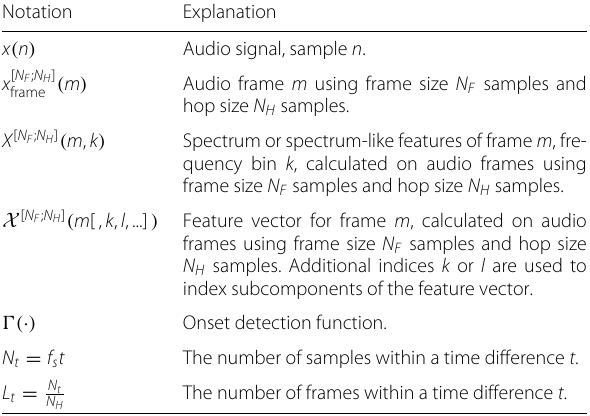
Table 2 Overview of mathematical notations used in this